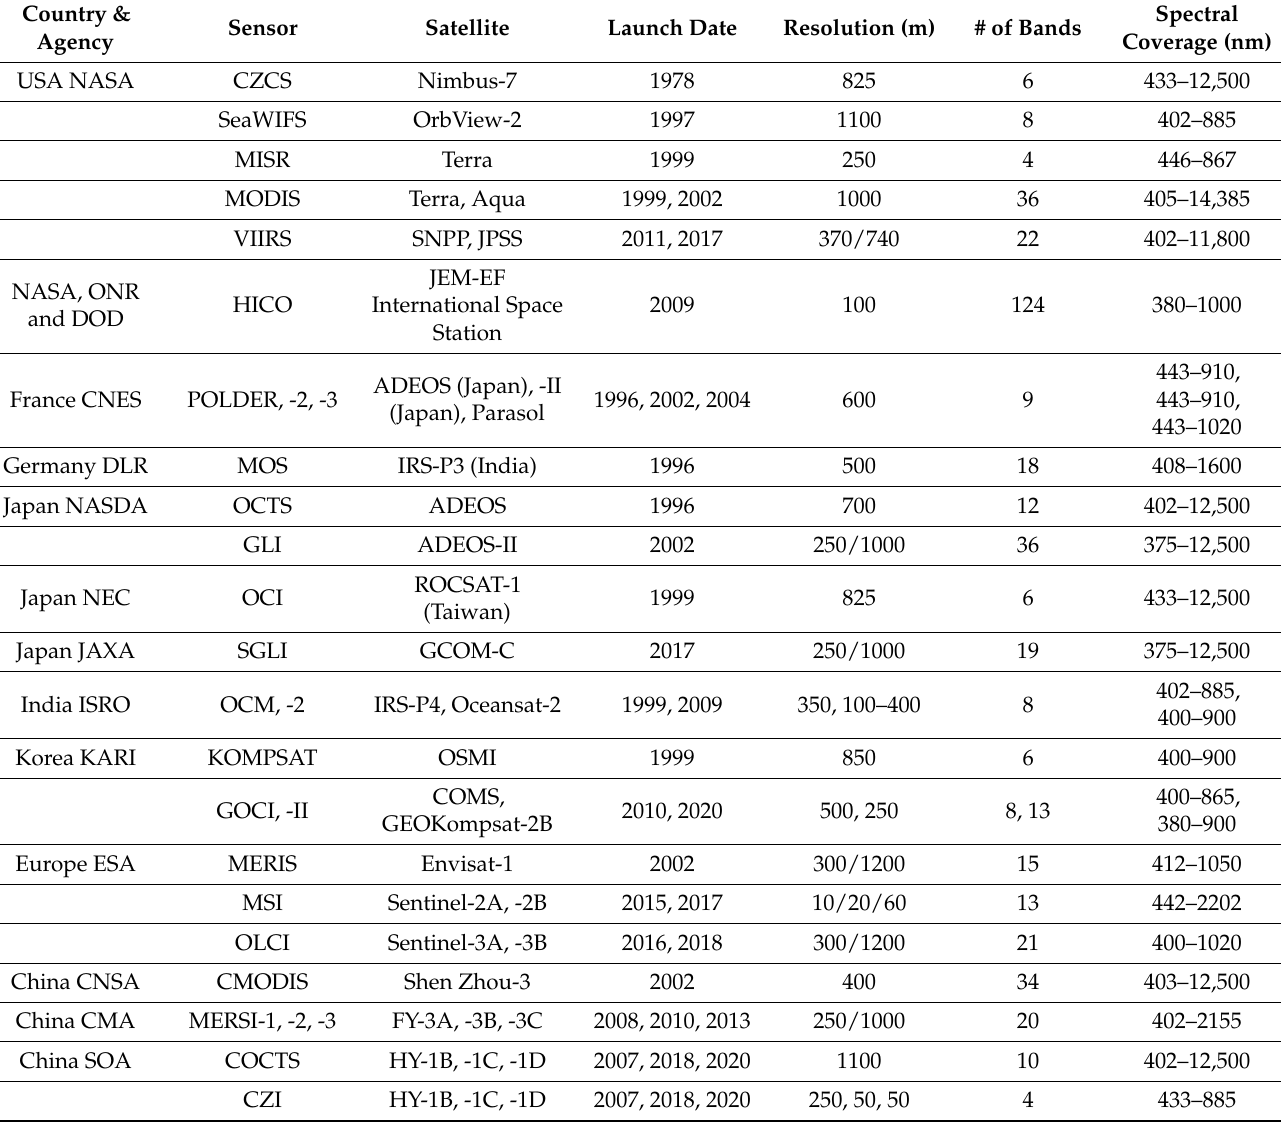
Table 1. Representative ocean color remote sensors from various agencies in different